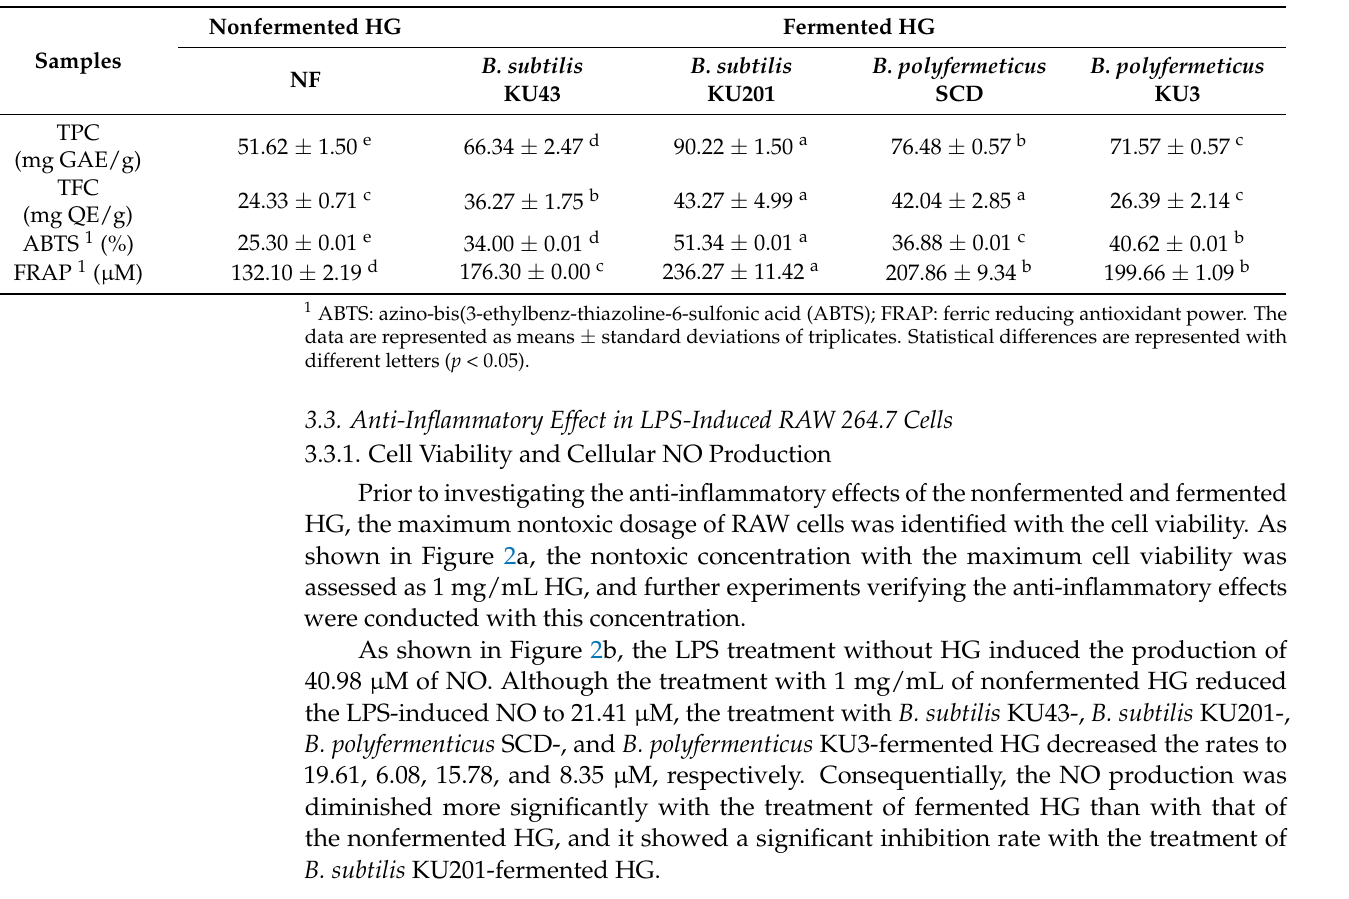
Table 2. Total phenolic content (TPC), total flavonoid content (TFC), and antioxidant activities of nonfermented and fermented hydroponic ginseng (HG).